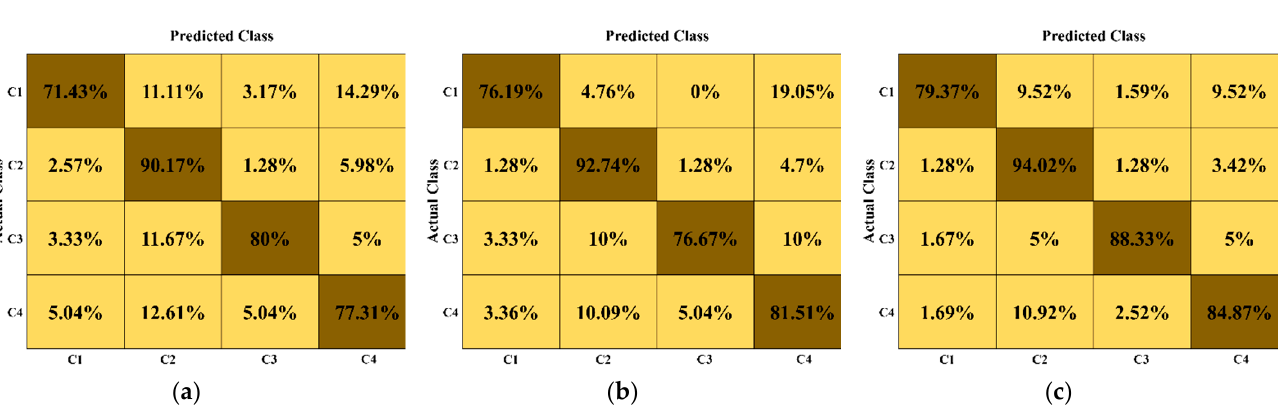
Figure 3. Significant performance gain of the proposed model using the t-test analysis in terms of accuracy (ACC), average precision (AP), average recall (AR), and F1.score (F1): ( a ) difference between the base model presented in [23] and the proposed model ( p -values), as well as the performance gain obtained using the proposed model compared to that of the base model [23], and ( b ) differ- ence between the base model presented in [27] and the proposed model ( p -values), along with the performance gain obtained using the proposed model compared to that of the base model [27].